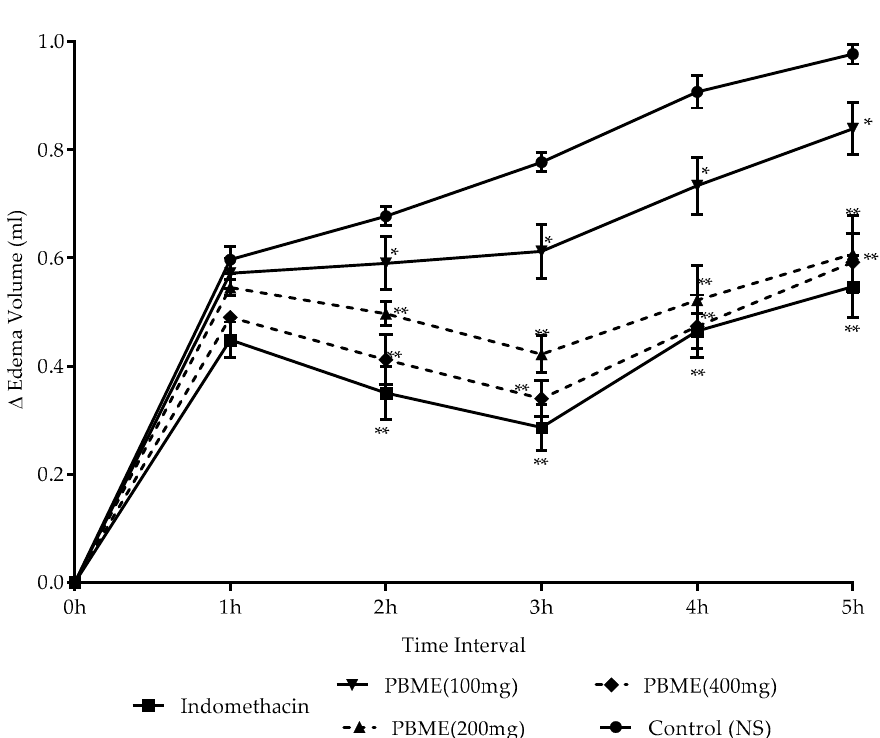
Figure 2. Difference ( ∆ ) edema volume (mL) on PBME, and indomethacin on rat paw edema induced by carrageenan. Values are mean ± SD ( n = 6). p -value measured by ANOVA followed with Dunnett’s test post hoc multiple comparisons. * p < 0.01 and ** p < 0.001 compared to control.